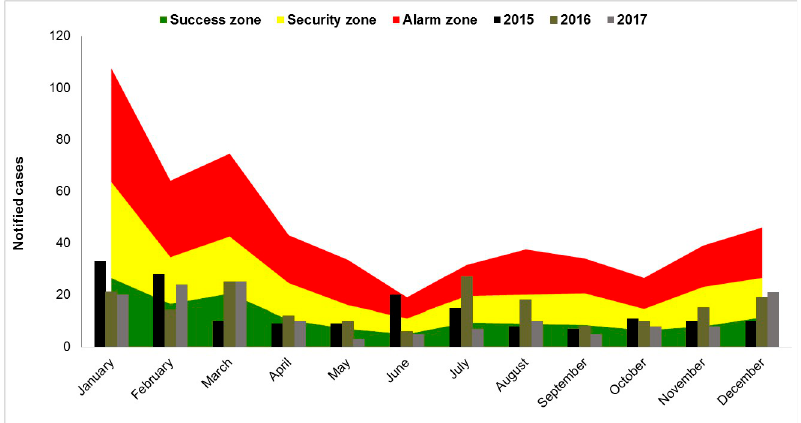
Fig 5. Monthly endemic channel built from registered malaria cases between 2000 and 2014 in Darie´n region, Panama. Success zone : the number of reported cases presents a lower frequency than expected. Security zone : the number of cases presents a stable pattern. Alarm zone : the number of reported cases presents a frequency that is higher than expected.